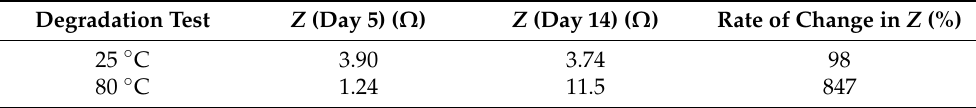
Table 2. Percentage change in Z in the 25 ◦ C and 80 ◦ C degradation tests.